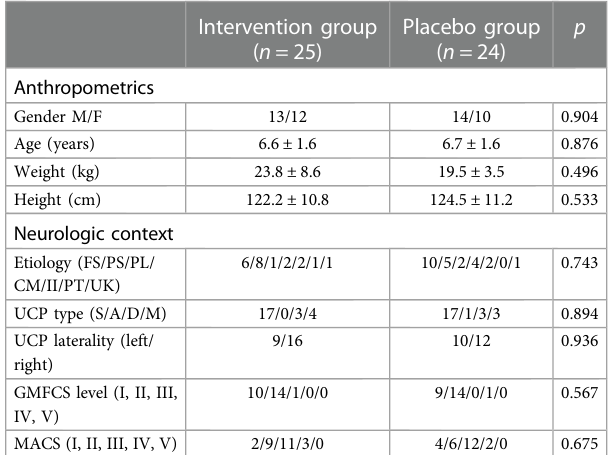
TABLE 1 Clinical characteristics of UCP children at baseline between allocation groups.